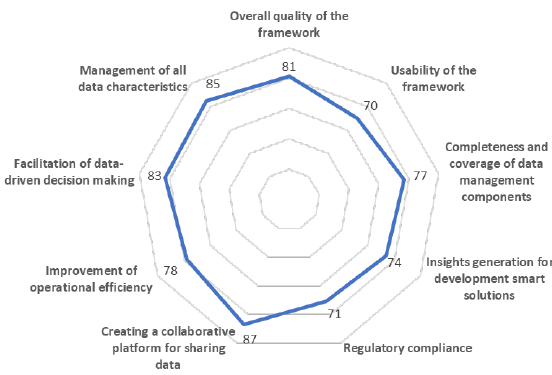
Figure 11 . Framework Evaluation by Subject Matter